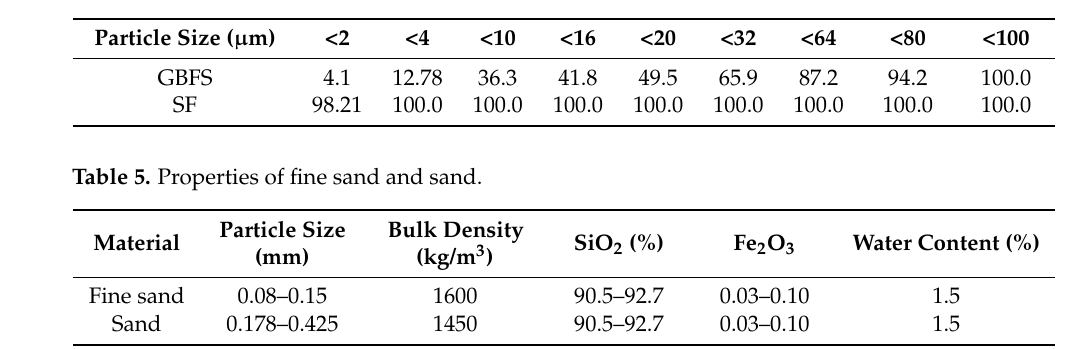
Table 4. Particle size of GBFS and SF.